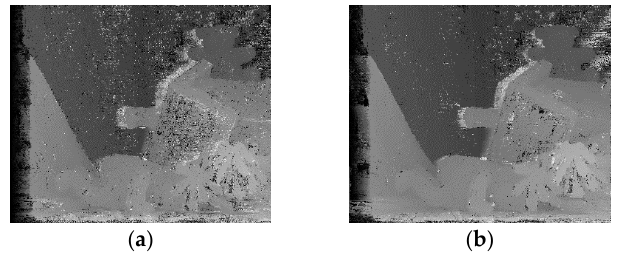
Figure 3. Initial matching cost results of ( a ) absolute difference (AD)-census and ( b ) sum of absolute difference (SAD)-census.